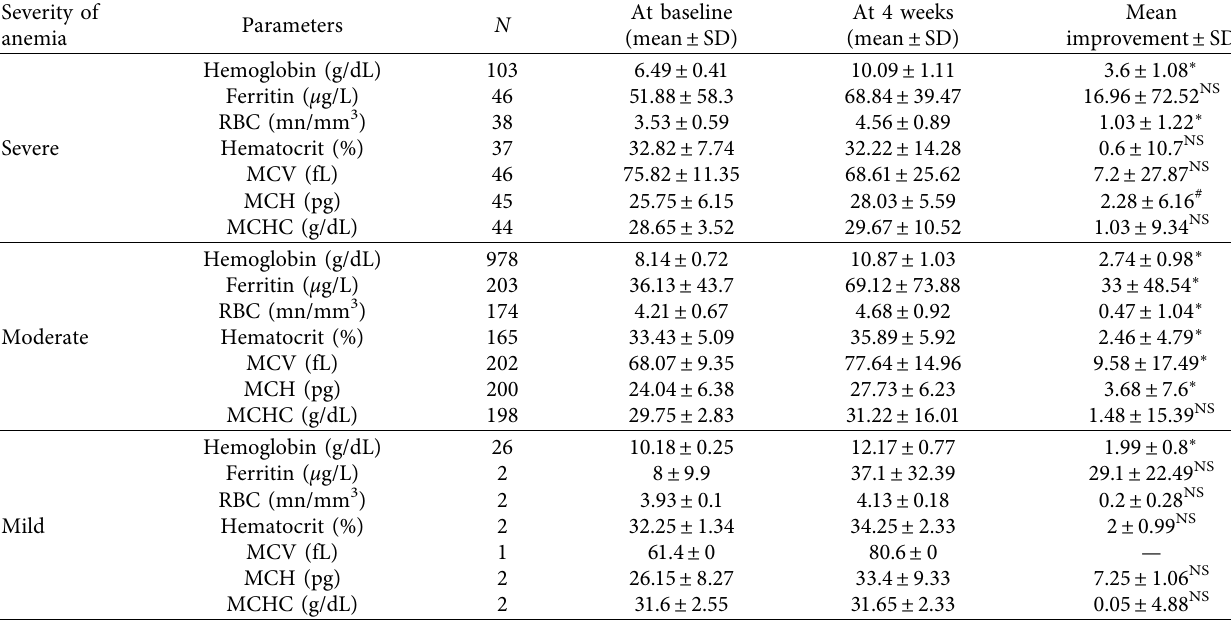
Table 4: Comparing hematological parameters before and after administration of ferric carboxymaltose by the severity of anemia Severity of anemia